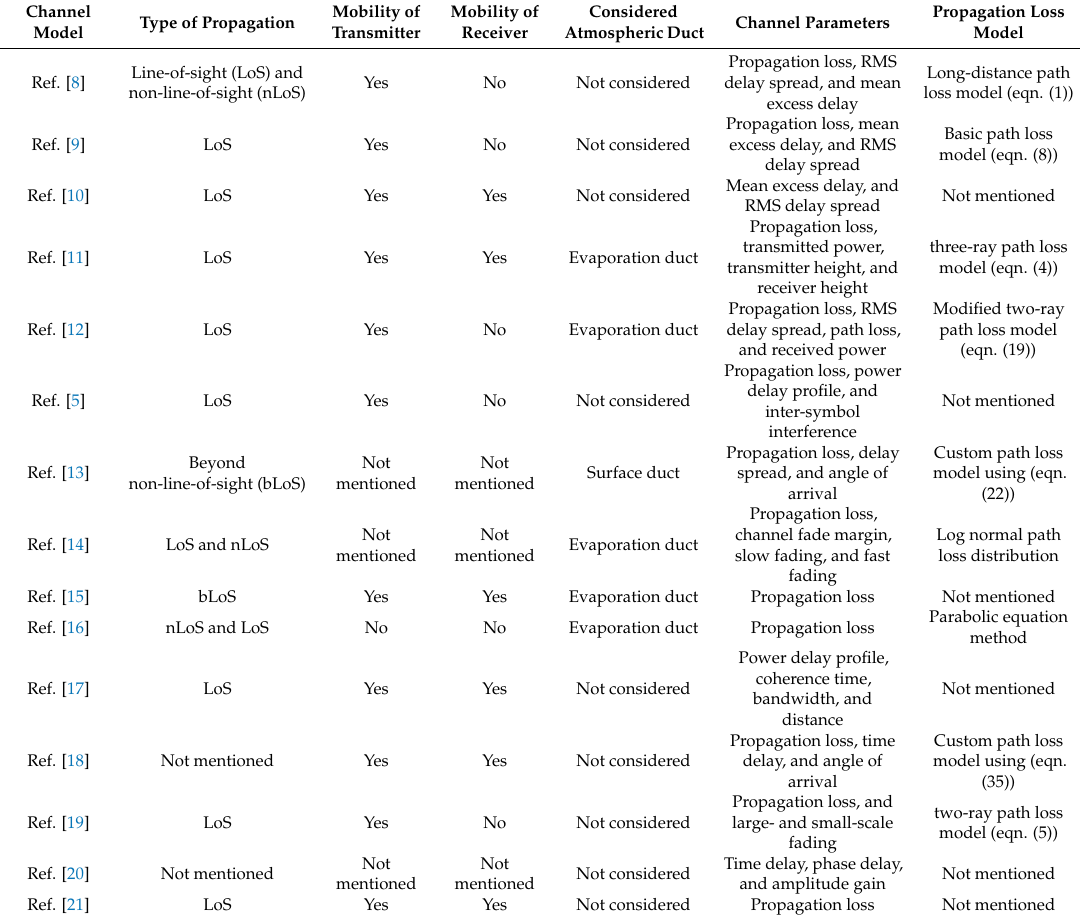
Table 2. Comparison of propagation environment and parameters.